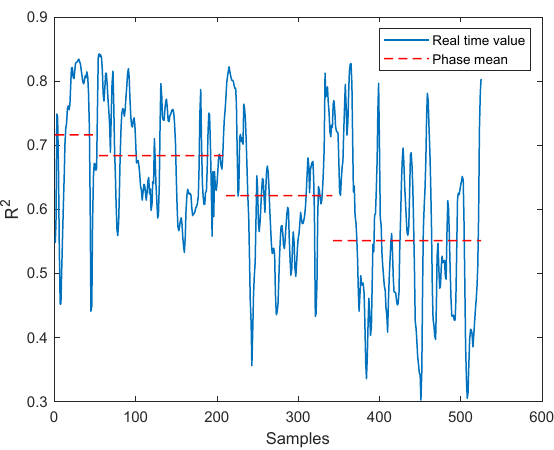
2 Figure 3. R 2 contribution rate of the different batches in mode 3. R k k Figure 3. contribution rate of the different batches in mode 3.